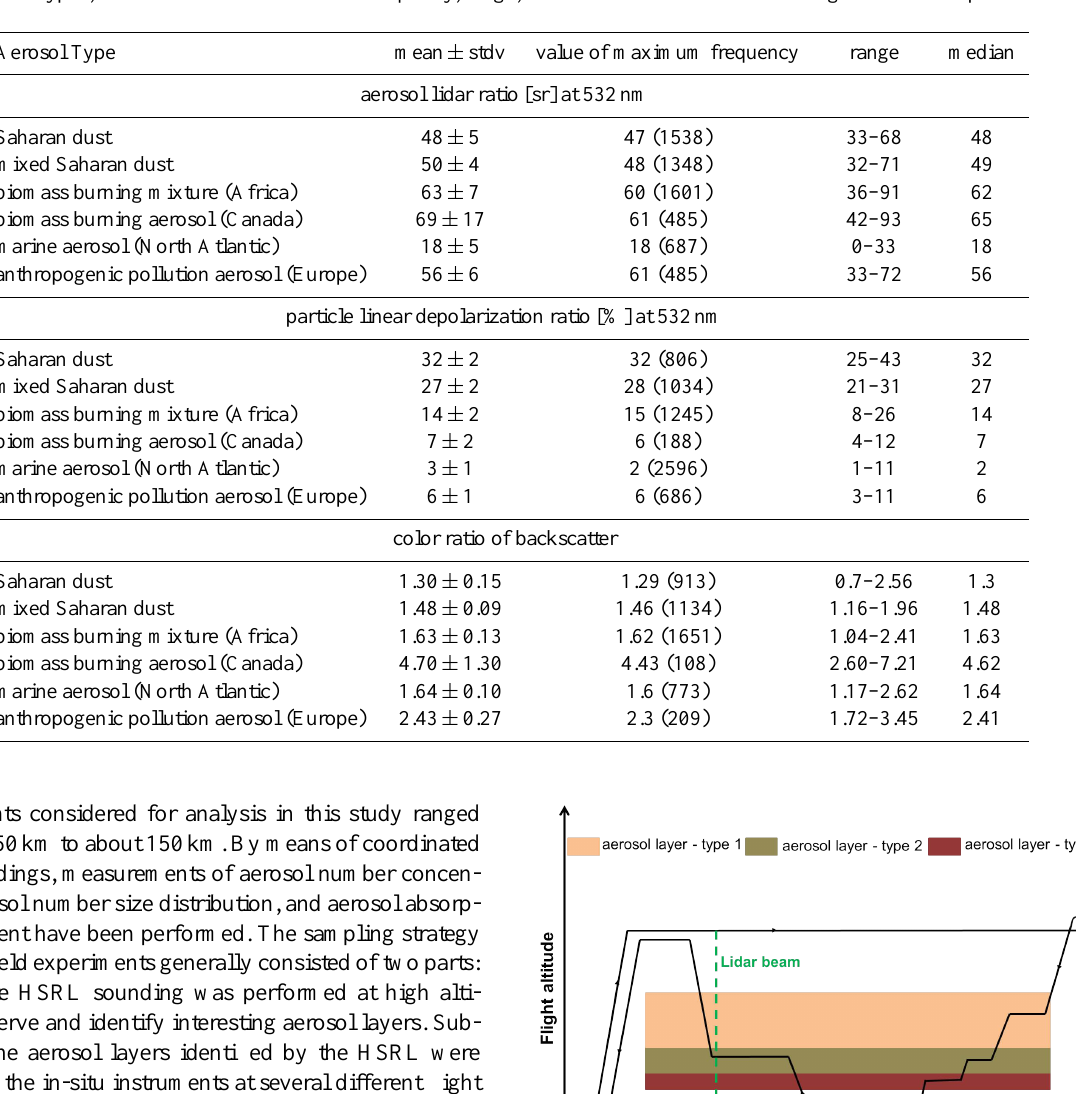
Table 2. Mean value ± standard deviation of aerosol lidar ratio, particle linear depolarization ratio and color ratio of backscatter for the examined aerosol types, as well as value of maximum frequency, range, and median. The data in brackets give the counts per bin.